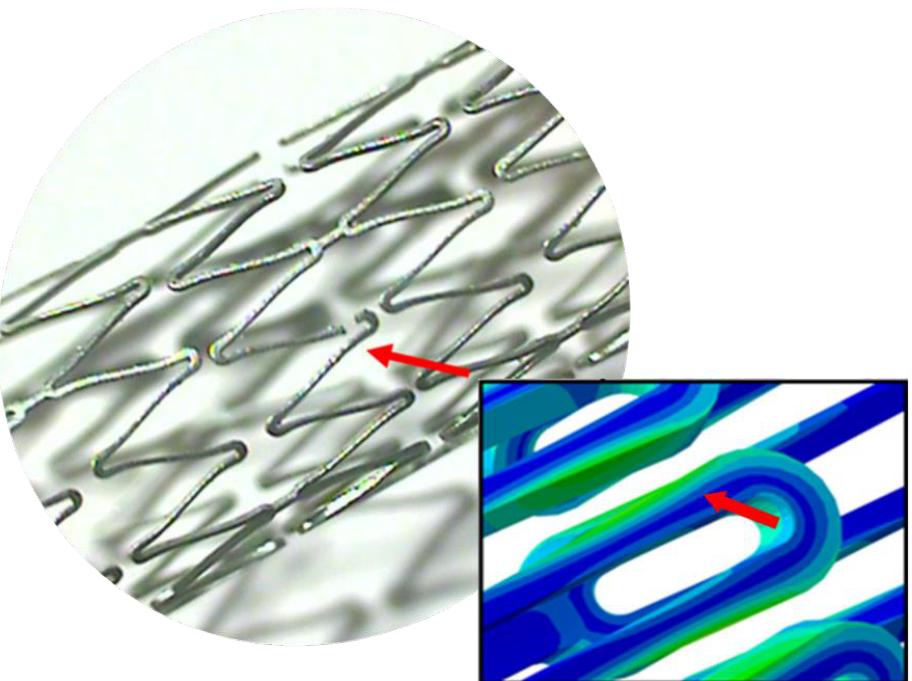
Figure 13. Stent fracture after the rotating bending fatigue testing. A one-tailed t -test was performed to determine if there was a statistically significant difference between the means of two variables for our case comparison (standard design vs. 40% tapered strut design; room temperature vs. body temperature). Like most other tests of significance, the threshold in a t -test is typically set at p = 0.05. If a p -value from a t -test is less than 0.05, then the result is considered to be statistically significant. Table 3 lists the calculated p -values from t -tests when evaluating the tapered-strut effect and the temperature effect, respectively. When the temperature was maintained at 23 ◦ C, there was a statistically significant difference ( p = 0.017) between the standard design and the 40% tapered-strut design. Similar result was also obtained for the case of 37 ◦ C, which showed statistically significant difference ( p = 0.036) between the two designs. On the other hand, when the stent design was made identical, there was no statistically significant difference ( p = 0.298 for the standard design and 0.498 for the 40% tapered-strut design) between two temperatures, suggesting again that temperature does not affect the stent fatigue life. Table 3. One-tailed t-test for evaluation of tapered-strut and temperature